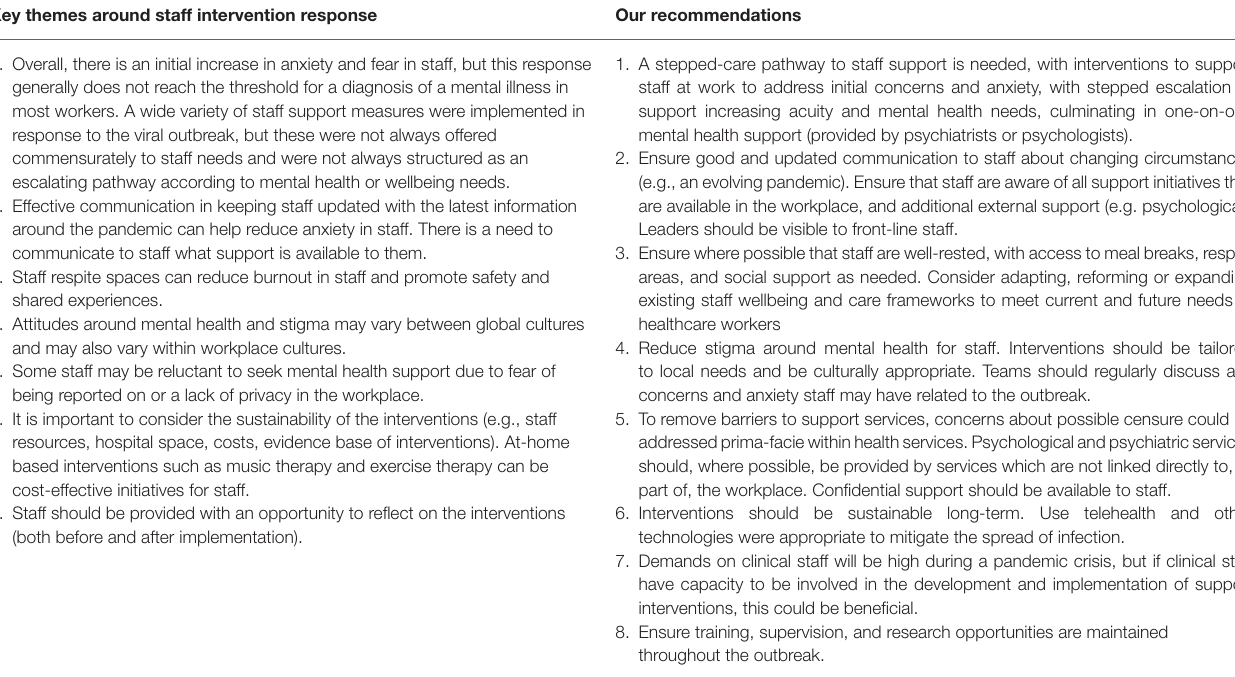
TABLE 2 | Key themes around staff interventional response to virial epidemics/pandemics and our recommendations. Key themes around staff intervention